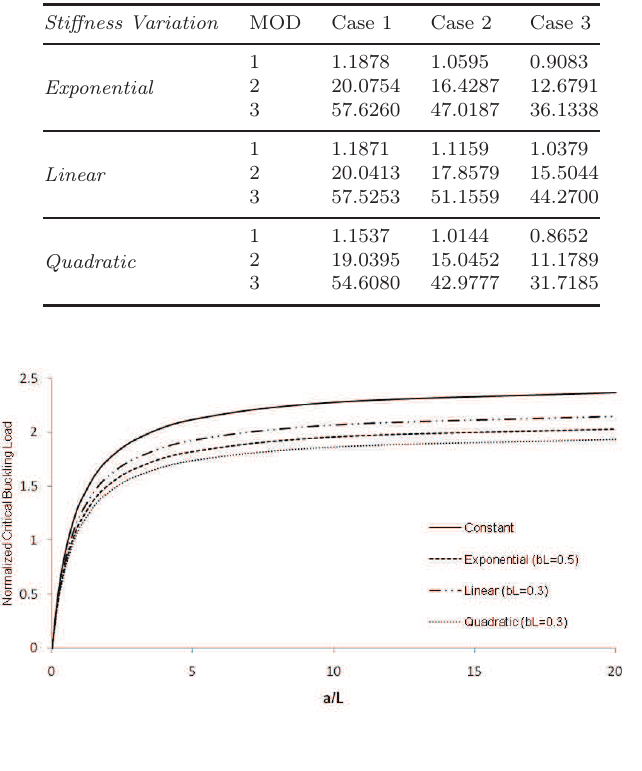
Figure 4. Variation of normalized critical buckling loads for different variable stiffness